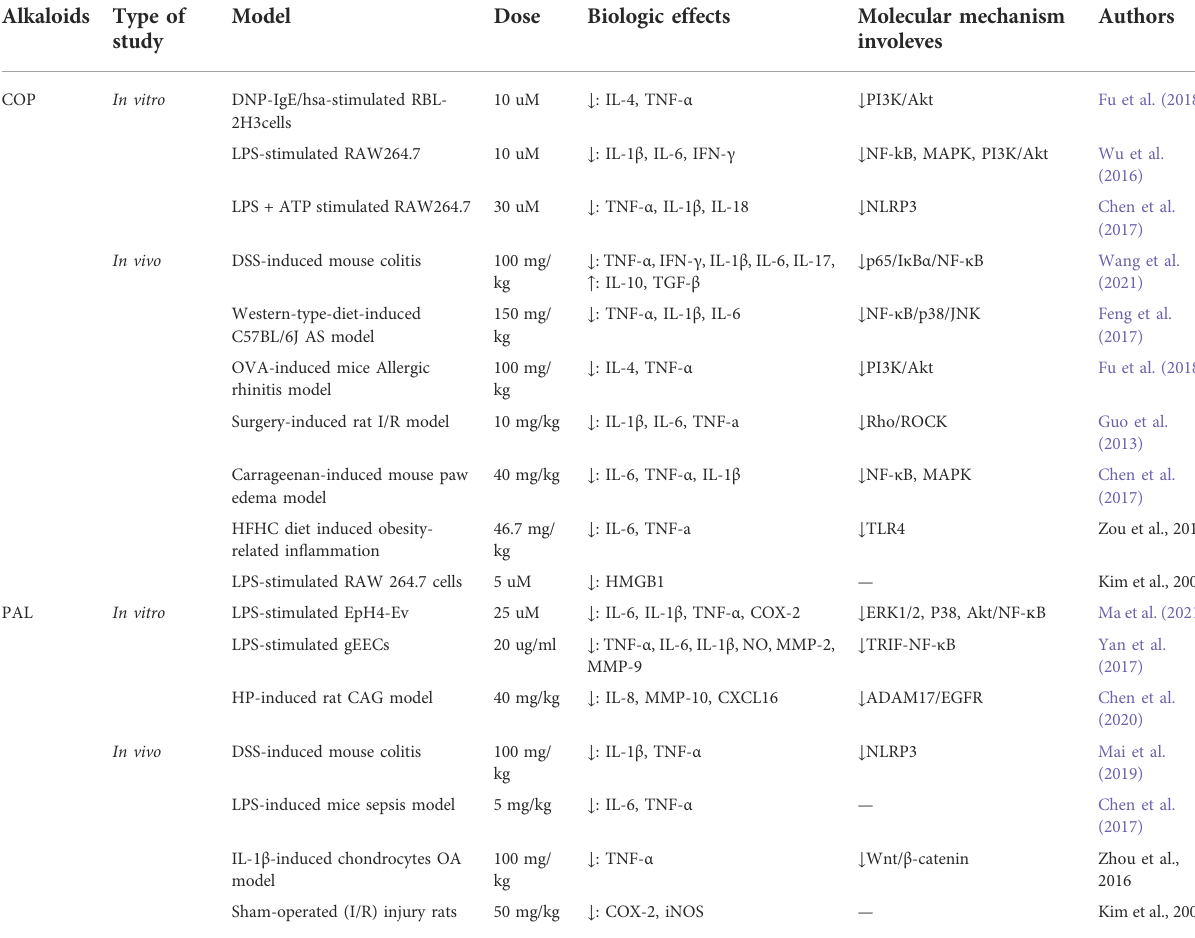
TABLE 2 The reported anti-in fl ammatory inhibition of coptisine and